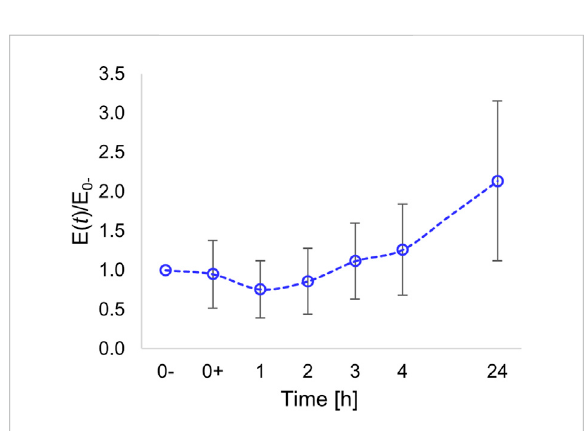
FIGURE 6 Time variation of Young ’ s modulus of the nuclear region normalized with respect to the modulus evaluated prior to pattern inscription (at time t = 0 -